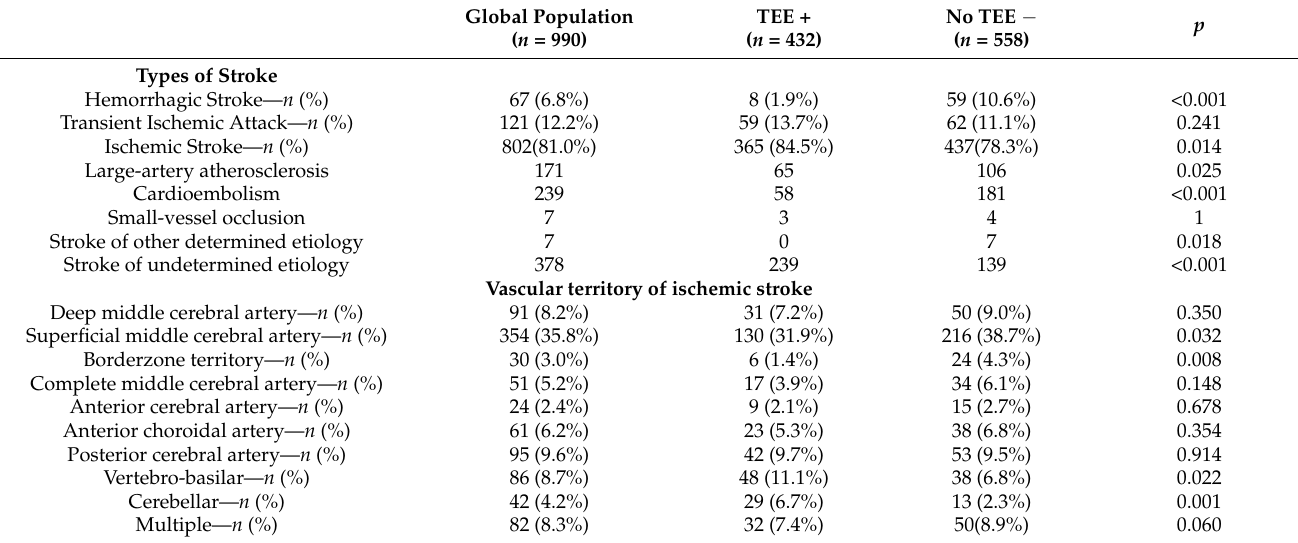
Figure 1. Central illustration. Transesophageal Echocardiography in Stroke Applied to an hospital-based Cohort. Legends— updated European and American guidelines have addressed the use of transesophageal echocardiography (TEE) in the field of stroke. Among 990 patients admitted for stroke in Strasbourg Stroke Center, France, 432 patients (42.6%) underwent TEE. A total of 227 examinations (52.5%) demonstrated abnormal findings and 31 examinations (7.1%) were followed by subsequent change in medical management. Abbreviations—TEE = Transesophageal Echocardiography. Table 1. Transesophageal Echocardiography Examination According to Stroke